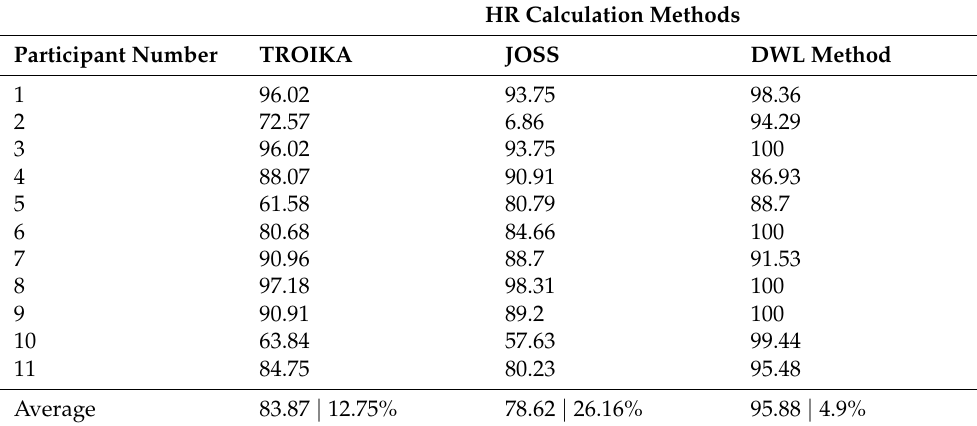
Table 4. PI in % for all eleven (11) experimental participants, using DWL, TROIKA, and JOSS (ideal PI is 100%). The last row shows the PI average of all eleven (11) participants shown as “mean | standard deviation”.